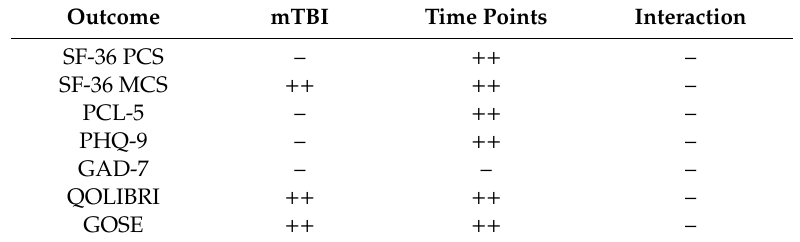
Table4. Overviewofdi ff erencesbetweenmTBIgroups, timepoints, andinteractionbetweenbothe ff ects.